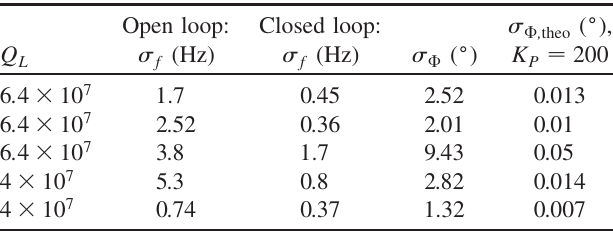
TABLE II. Achieved reduction of the cavity detuning and corresponding phase stability. Also listed in the last column is the theoretical phase stability if an LLRF system with gain 200 were included. The third row shows a result where high pressure variations occurred.